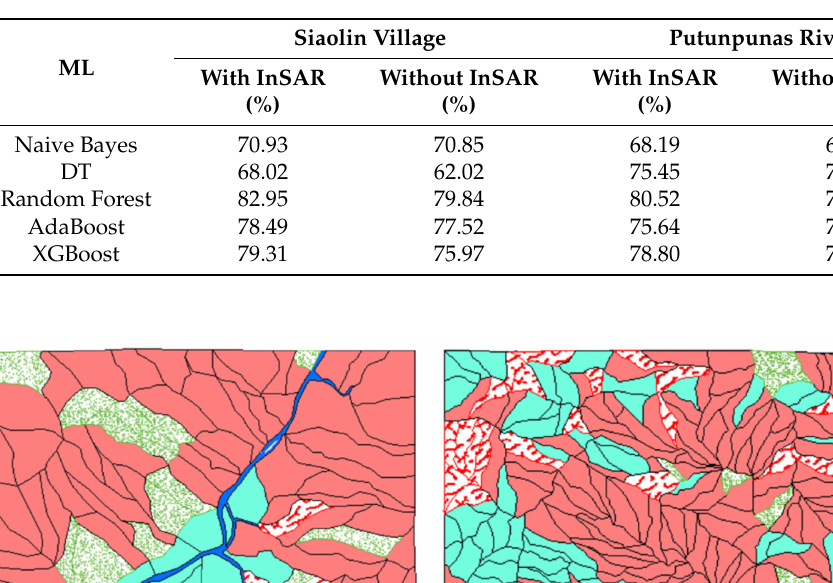
Table 3. Average prediction accuracies before and after including InSAR data in different ML meth- ods.